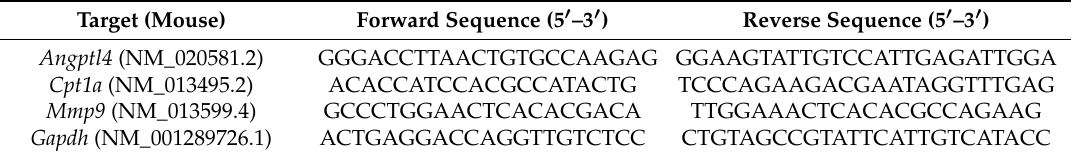
Table 1. Sequences of the forward and reverse primers utilized for gene expression analysis. Target (Mouse) Forward Sequence (5 (cid:48) –3 (cid:48)